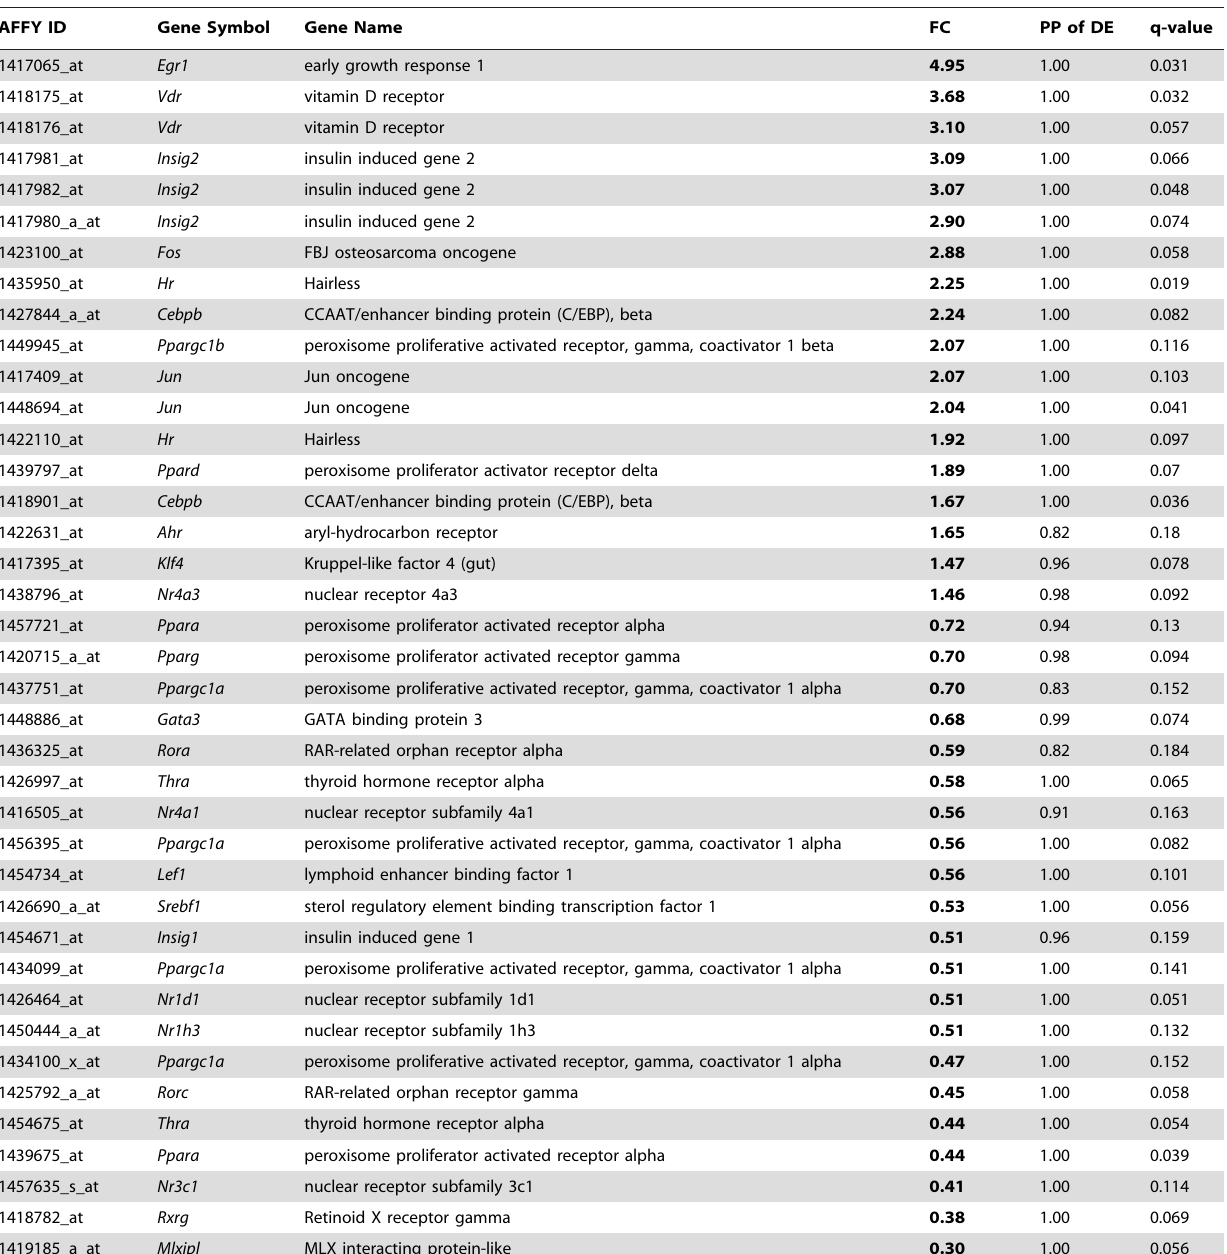
Table 6. Transcription factors and co-activators.